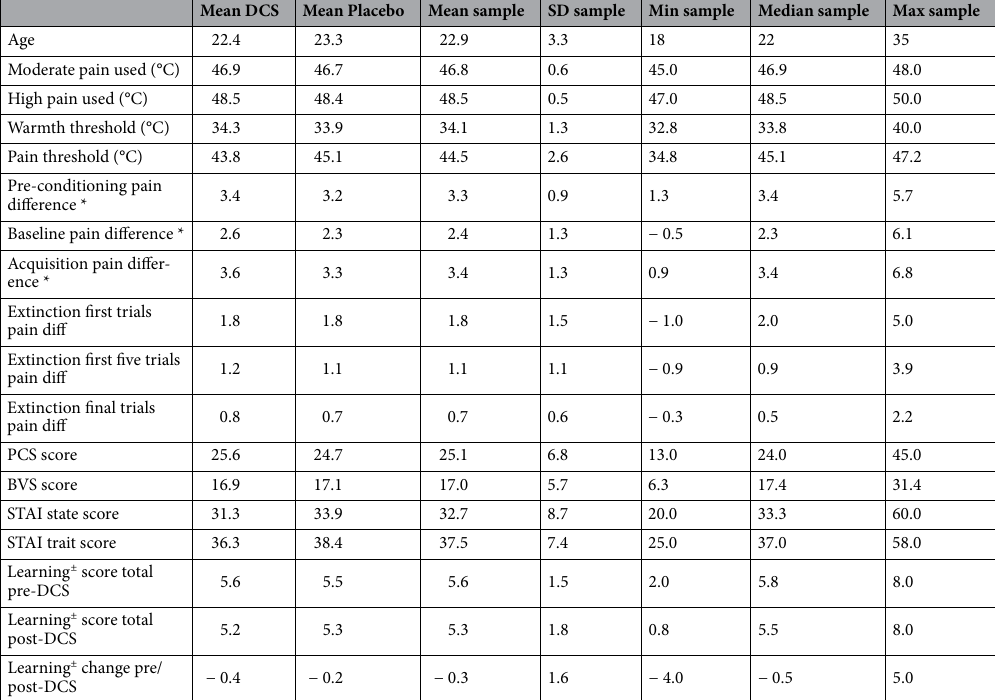
Table 1. Descriptive statistics of demographics, temperatures used, pain ratings, questionnaires, and learning rates. All temperatures are reported in degrees Celsius. PCS, Pain Catastrophizing Scale; BVS, Body Vigilance Scale; STAI, Spielberger State-Trait Anxiety Inventory; DCS, D-cycloserine. *Pain differences represent the mean NRS difference between nocebo/high pain trials minus control/moderate pain trials for each phase. In extinction, the first pair of trials (evocation), first 10 trials, and final 18 nocebo and control trials are reported. ± Learning was measured as a manipulation check with the Wechsler Memory